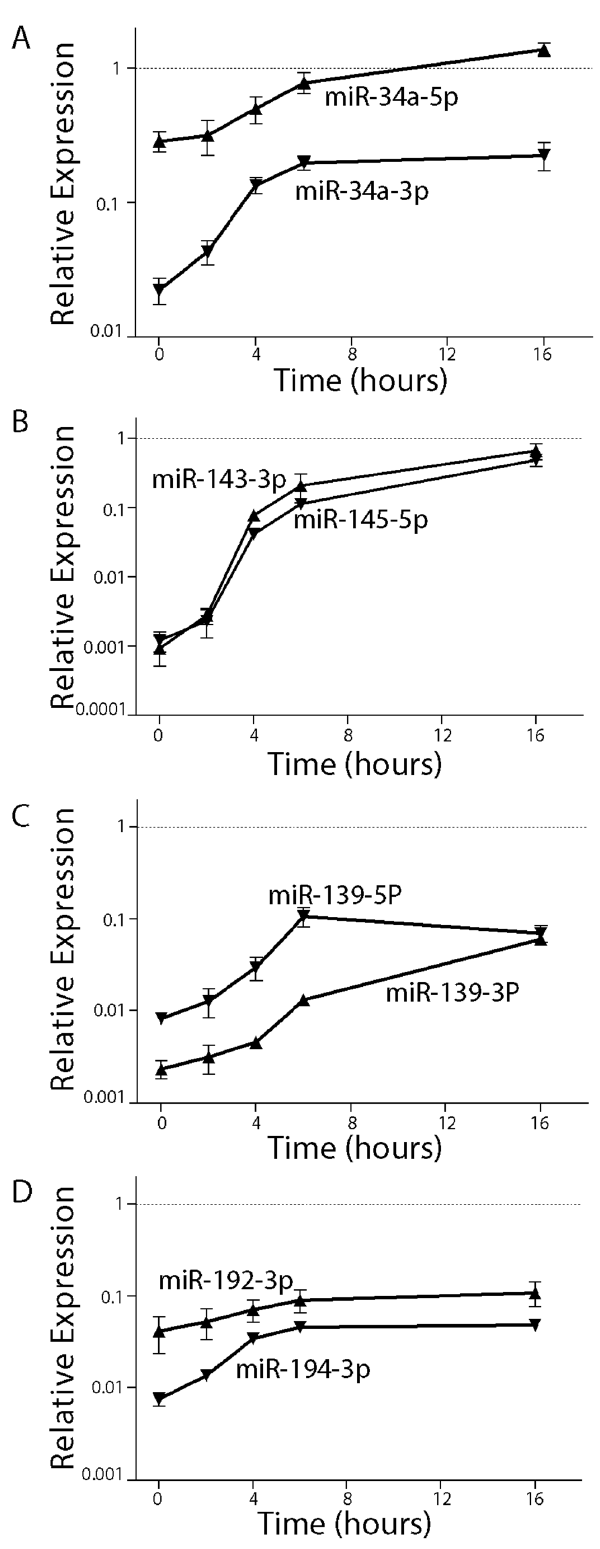
Fig 3. Comparison p53-induced miRNAs to reference RNA levels. CT values were used to compare the indicated miRNA (A-D) to miR-103 and miR-191 expression. Samples were collected following incubation at